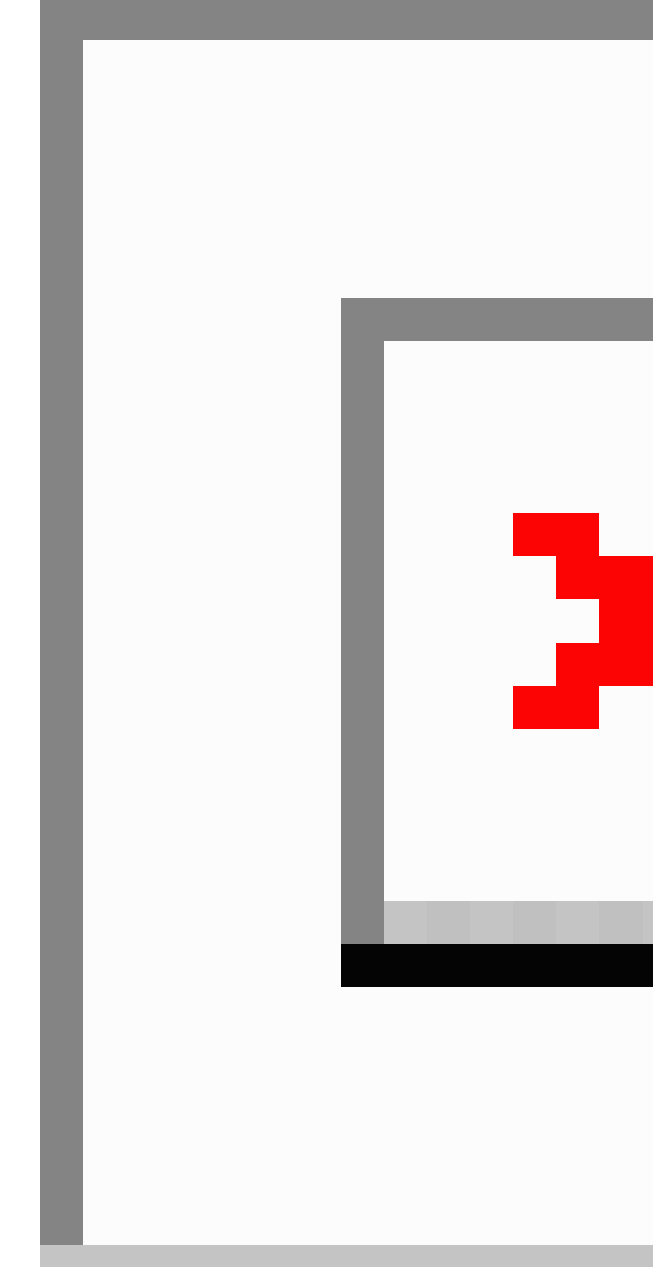
Figure 4. ABAL trial of SeeCare IPTV by a patient and a